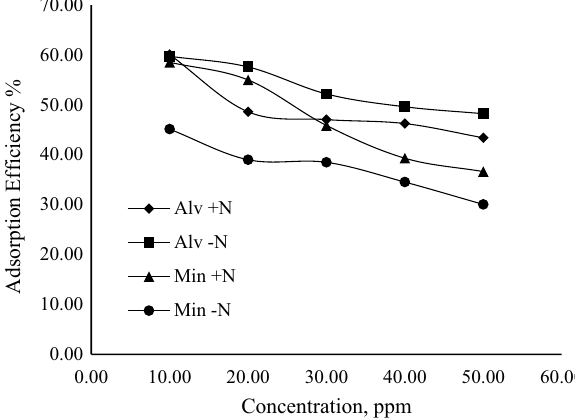
Fig. 2 Effect of initial ion concentration on the adsorption efficiency of Cd 2+ onto N. alveolaris + N, N. alveolaris –N, N. minuta + N, and N/ minuta –N algae